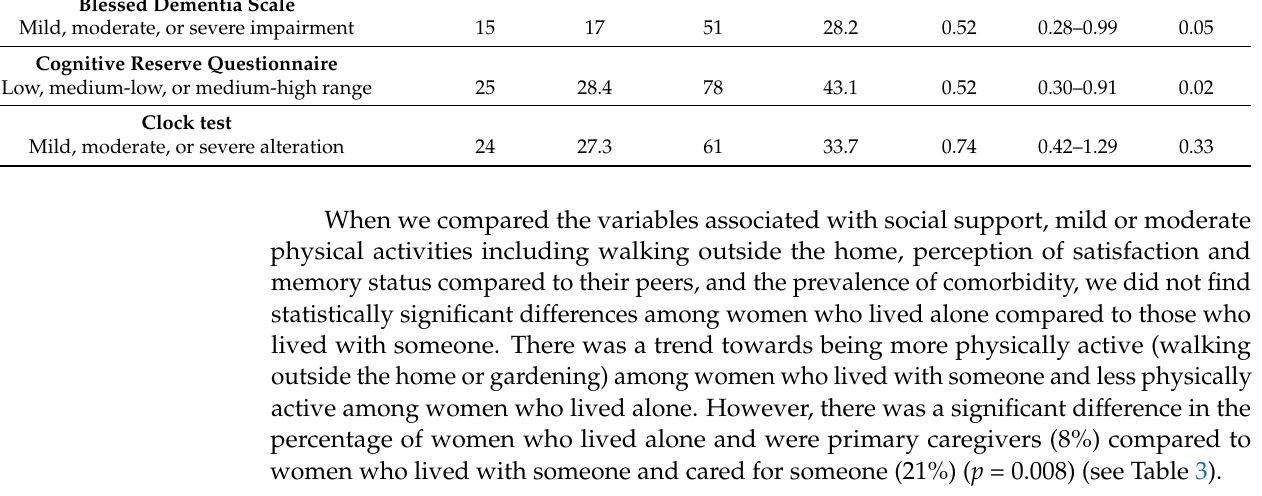
Table 3. Association between living alone or with someone, social and physical activities, and comorbidity variables. Variable